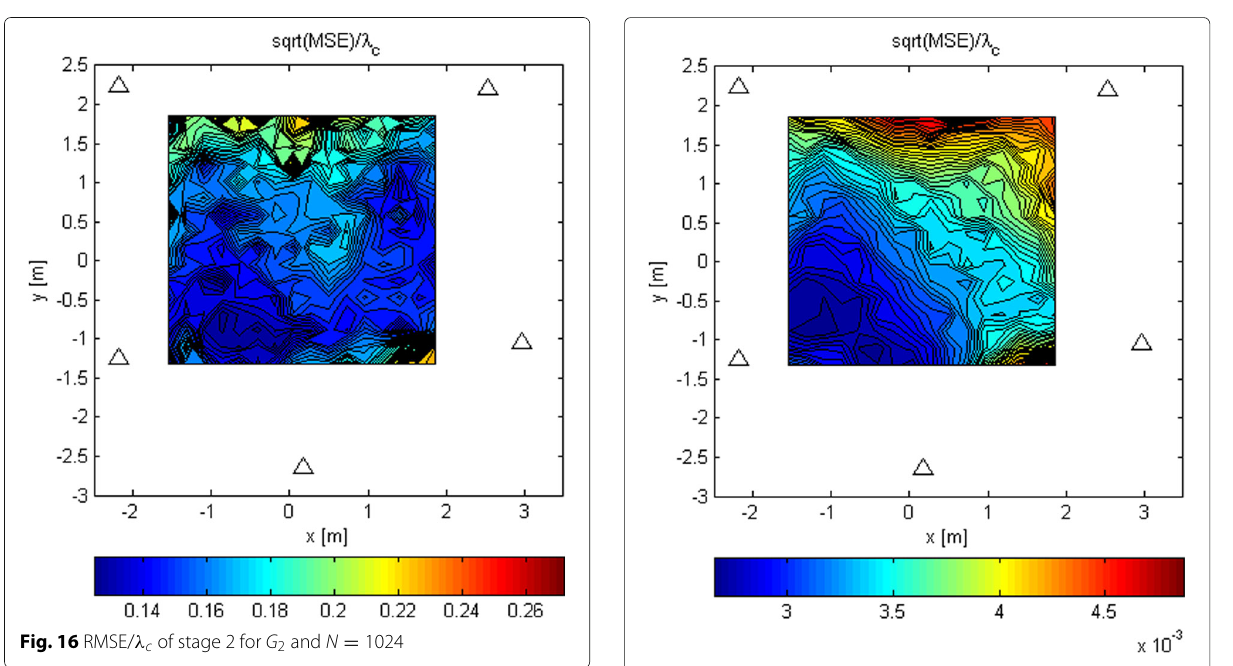
Fig. 18 RMSE/ λ c of stage 3 and N = 1024 when the main lobe is not missed Monte Carlo simulations for every Tx grid point and computed from them the RMSEs. The same results but for G 2 , and N = 16 and N = 1024, are presented in Figs. 15 and 16. These results are better because of the increased space between the antennas in the subarrays.